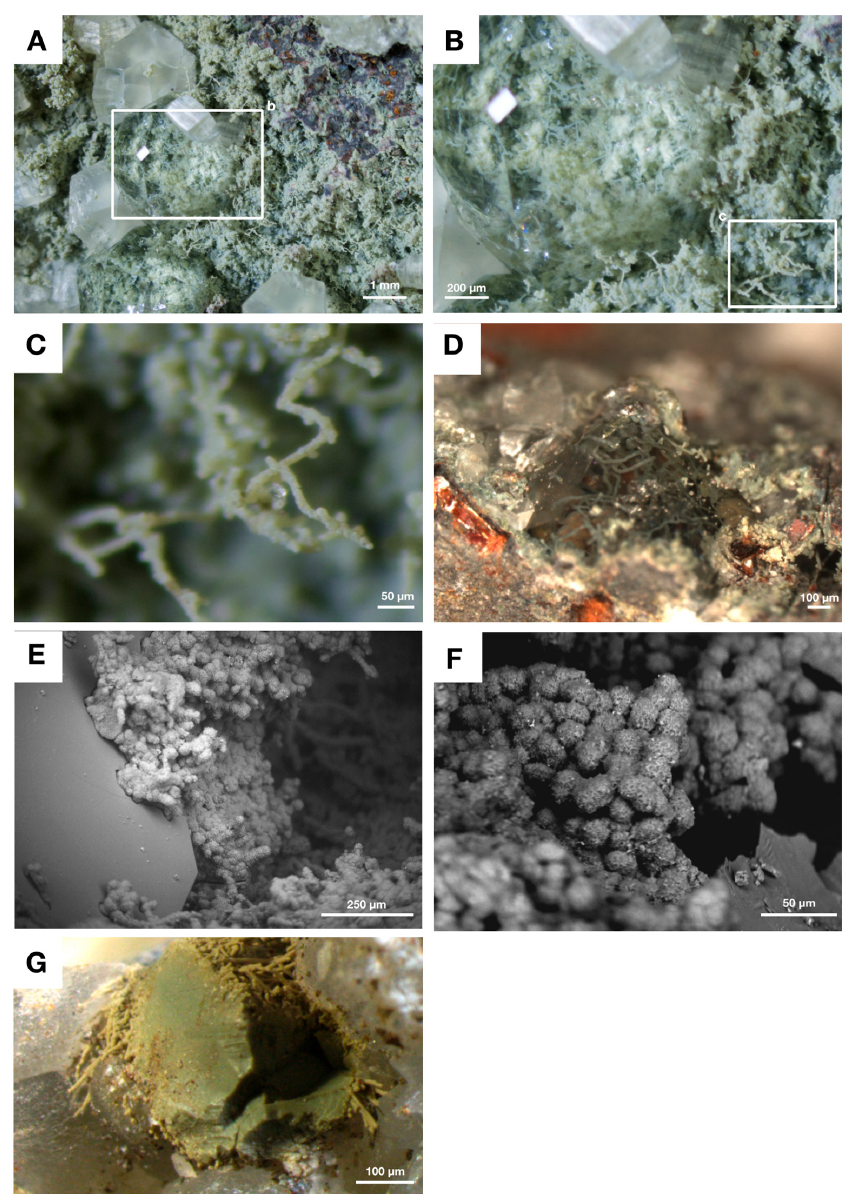
Figure 5. Stereo ( A – D , G ) and Scanning Electron micrographs showing fungal biofilm with yeast- like structures preserved in green clay from samples 1205-34R-5 ( A – F ) and 1206A-024R ( G ), Nintoku seamount. ( A ) Open fracture exposing filamentous fungal biofilms preserved in clay, partly intergrown and overgrown by zeolites (translucent minerals) with dark Mn-oxides present. Boxed area is magnified in (B). Scale bar is 1 mm. ( B ) Close-up of boxed area from (A) showing clay mineralixed hyphae intergrown with zeolite crystal. Boxed area is magnified in (C). Scale bar is 200 µ m. ( C ) Close-up of boxed area from (B). Evenly preserved clay mineralized fungal hyphae with spore-like structures attached. Scale bar is 50 μ m. ( D ) Fungal mycelium intergrown with zeolites. Scale bar is 100 µ m. ( E ) Fungal biofilm with yeast-like cells attached to the surface. Scale bar is 250 µ m. ( F ) Close-up of yeast-like cells from fungal biofilm. All cells and hyphae are preserved as authigenic clays. Scale bar is 50 μ m. ( G ) XRD and Mössbauer-run sample 1206A-024R, showing green clay mineralized fungal filaments. Scale bar is 100 μ m.